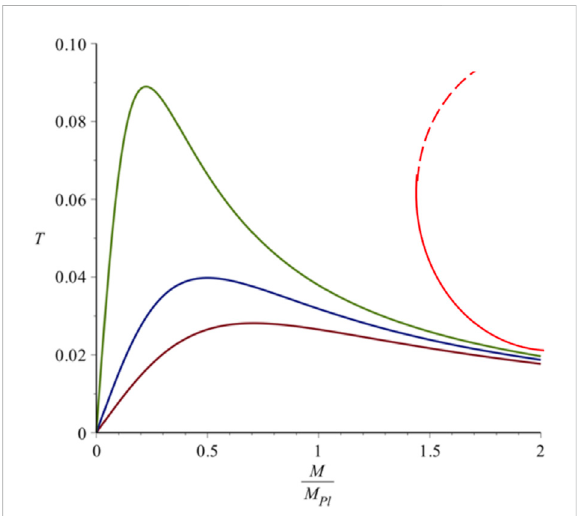
FIGURE 2 Hawking temperature (in Planck units) from Eq. 3 and surface gravity argument as a function of M / M P for β = 1 (bottom), β = 0.5 (middle) and β = 0.1 (top). Also shown on the right is the Adler prediction. From Carr et al.